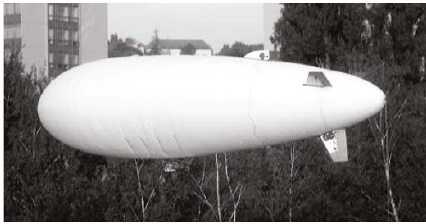
Figure 1: Remote-controlled